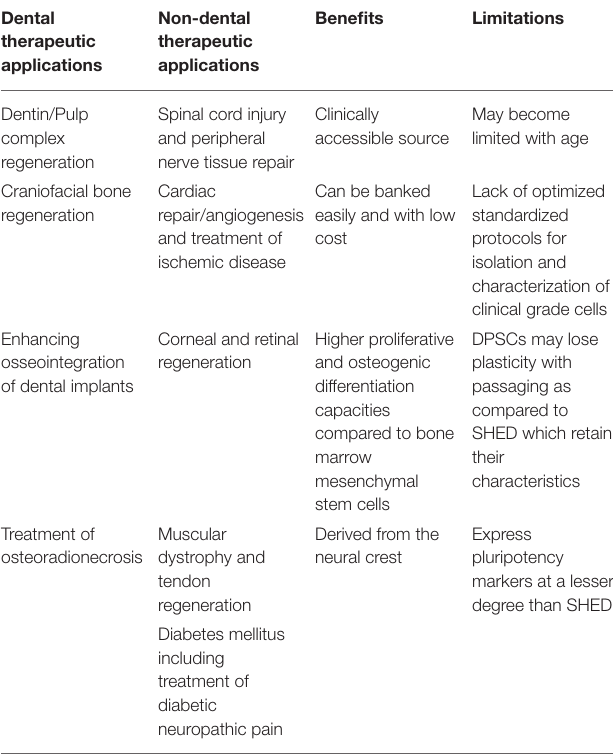
TABLE 1 | A summary of the dental and non-dental therapeutic applications of dental pulp stem